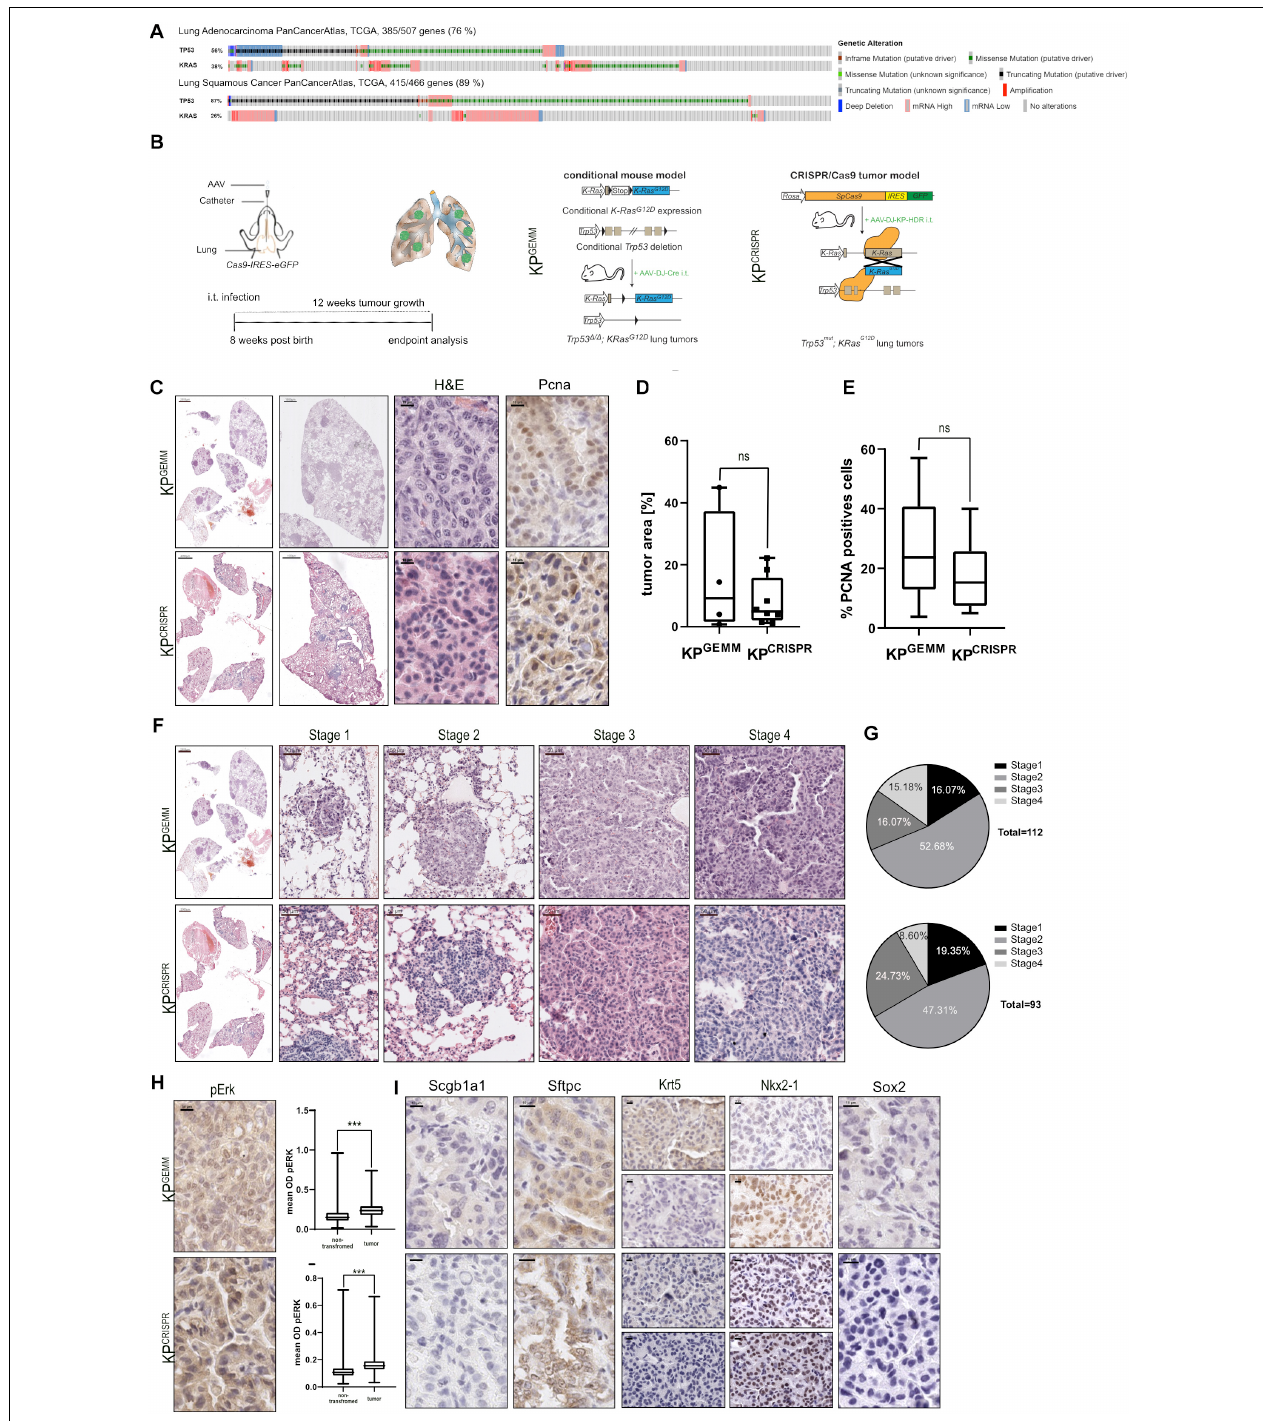
FIGURE 1 | CRISPR/Cas9-mediated editingP of Trp53 and KRas G 12 D ( KP Crispr ) induces the formation of NSCLC that is indistinguishable from the classic GEMM model Trp53 fl / fl :KRas lsl − G 12 D / wt ( KP GEMM ). (A) Analysis of occurring alterations in TP53 and KRAS in lung adenocarcinoma (upper panel) and lung squamous cancer (lower panel) (www.cbioportal.org). (B) Schematic diagram of the intratracheal tumor induction in C57BL6/J Trp53 fl / fl :KRas lsl − G 12 D / wt ( KP GEMM ) via AAV-DJ-Cre and CRISPR/Cas9-mediated tumor modeling and targeting of p53 (cid:49) ; KRas G 12 D in Rosa 26 Sor − CAGG − Cas 9 − IRES − GFP mice (KP CRISPR ). (C) Representative H&E images of tumor-bearing animals 12 weeks post intratracheal infection (scale bars 2,000, 1,000, and 10 µ m) and representative IHC analysis of PCNA. KP GEMM n = 4; KP CRISPR n = 8. (D) Quantification of % tumor area (normalized to total lung area) in KP GEMM n = 4 and KP CRISPR n = 8. The p value ( p = 0.3423) was calculated using an unpaired two-tailed t test. (E) Quantification of % PCNA-positive cells in KP GEMM and KP CRISPR tumors with n > 20,000 events, respectively. The p value